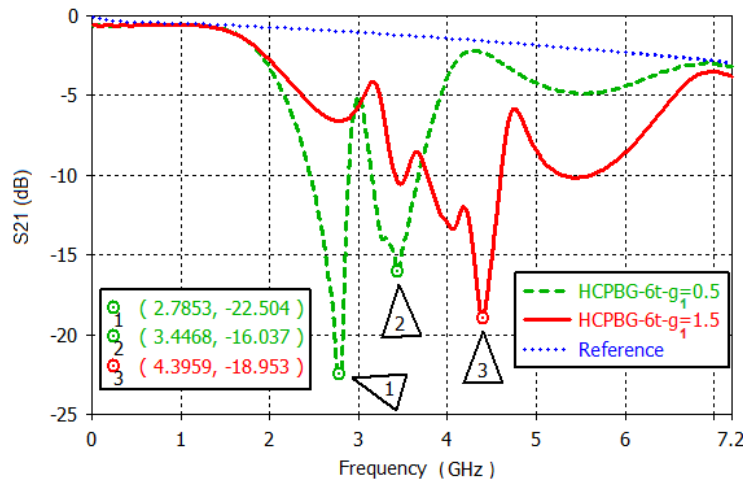
Figure 6. Simulation—transmission loss for HCPBG with 6 traces—gap distances 1.5 and 0.5 mm.